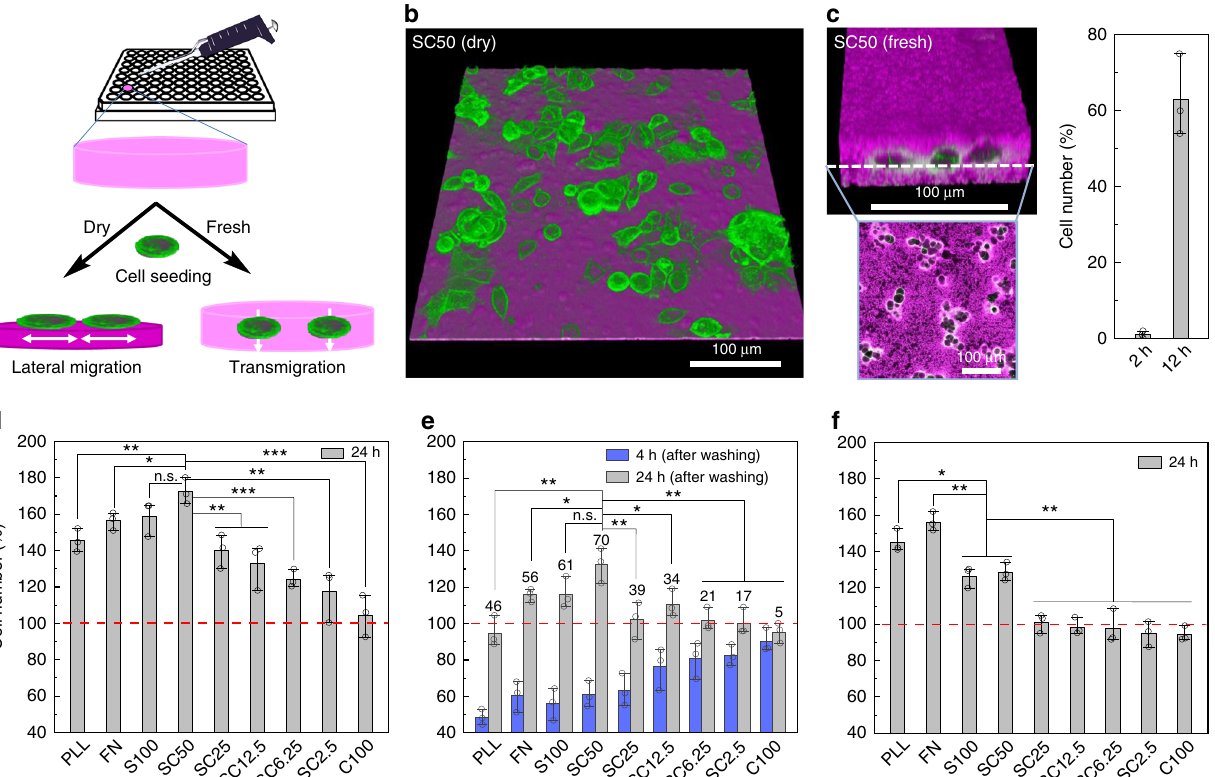
Fig. 4 Viability, proliferation, and migration of MCF7 eGFP cells adhered on nanocomposite fi lms. a Schematics of preparing fully hydrated ( “ fresh ” ) or dehydrated ( “ dried ” ) nanocomposite fi lms for cell cultivation. b Representative fl uorescence microscopy image of MCF7 eGFP cells (green) after adhesion on dried SC50 (magenta). c MCF7 eGFP cells transmigrate into fresh SC50, as indicated by the number of cells detected in the central layer of SC50 after 2 h and 12 h, respectively; the insets show a 3D image and the 2D section of the central layer of the cell-populated hydrogel after 12 h. d , e , f Quanti fi cation of cells grown for 24 h on dried ( d , e ) or fresh ( f ) nanocomposite fi lms. Cell numbers were determined by the CCK-8 assay and normalized to data obtained after adhesion for 4 h (red dashed line). The bars in e represent numbers of cells that remained on the substratum after adhesion for 1 h, thorough washing and subsequent cultivation for additional 4 h or 24 h (blue or gray bars, respectively, numbers on top indicate the percentage change). All data are represented by mean ± S.D. of triplicate